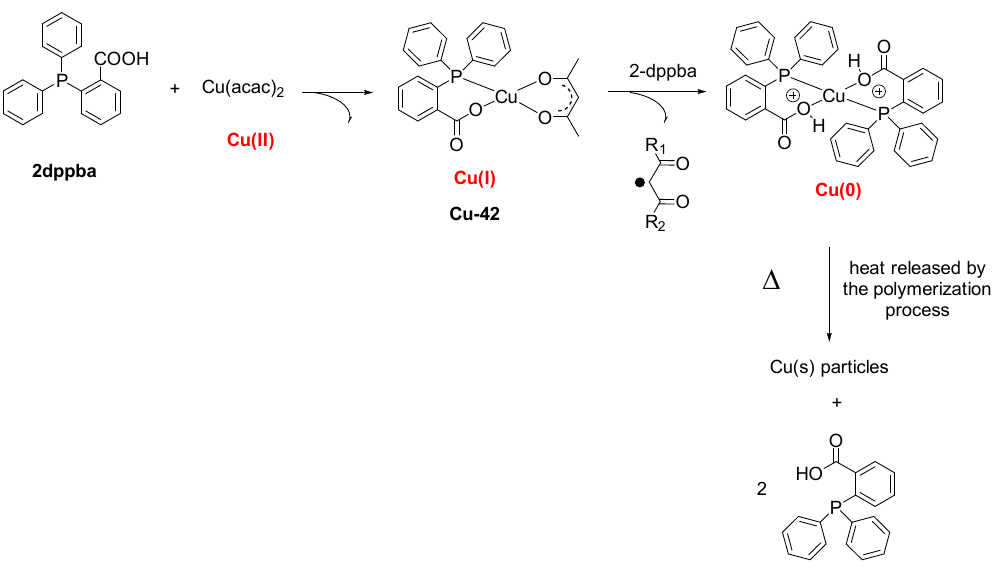
Figure 36. Monitoring of the synthesis of Cu-42 over time. Reproduced with permission from the authors of [69]. Copyright 2017 John Wiley & Sons Ltd. Indeed, as shown in Figure 37, a faster polymerization process was found with the mechanosynthesized Cu-42 during the FRP of the (1,4-BDMA/HPMA/UDMA) blend under air. Due to the presence of unreacted Cu(acac) 2 within the powder, a parallel reaction between Cu(acac) 2 and 2-dppba could occur, speeding up the polymerization kinetic [69]. Besides, similar final monomer conversions (81%) could be found with the two-component Cu-42 /2-dppba (1%/1.5% w / w ) systems, irrespective of the method used to prepare Cu-42 . Conversely, due to the low solubility of Cu(acac) 2 in methacrylate resins, a lower final monomer conversion was determined, peaking at 68% after 120 s of reaction. Therefore, in light of the difference of solubility, Cu-42 is from this point of view more interesting than Cu(acac) 2 . As another topic of interest, almost colorless coatings could be obtained with Cu-42 , whereas a marked color could be detected for the polymer films prepared starting from Cu(acac) 2 [69].